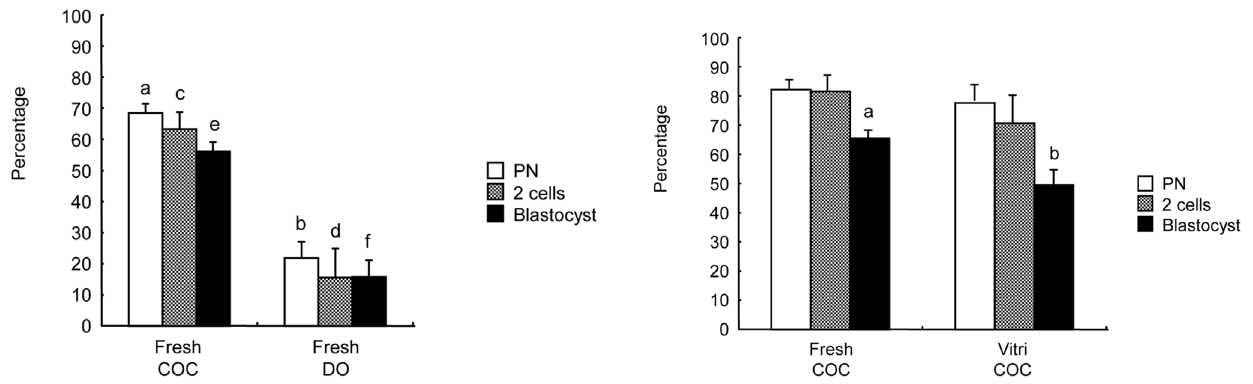
Fig. 3. Fertility and developmental ability of vitrified-warmed cumulus oocyte complexes (COCs) after IVF in C57BL/6J mice. IVF was carried out using fresh C57BL/6J mouse sperm. Data are means 6 S.E.M. Different superscripts denote significant difference ( P , 0.05). In each treatment group, more than 100 oocytes were examined.